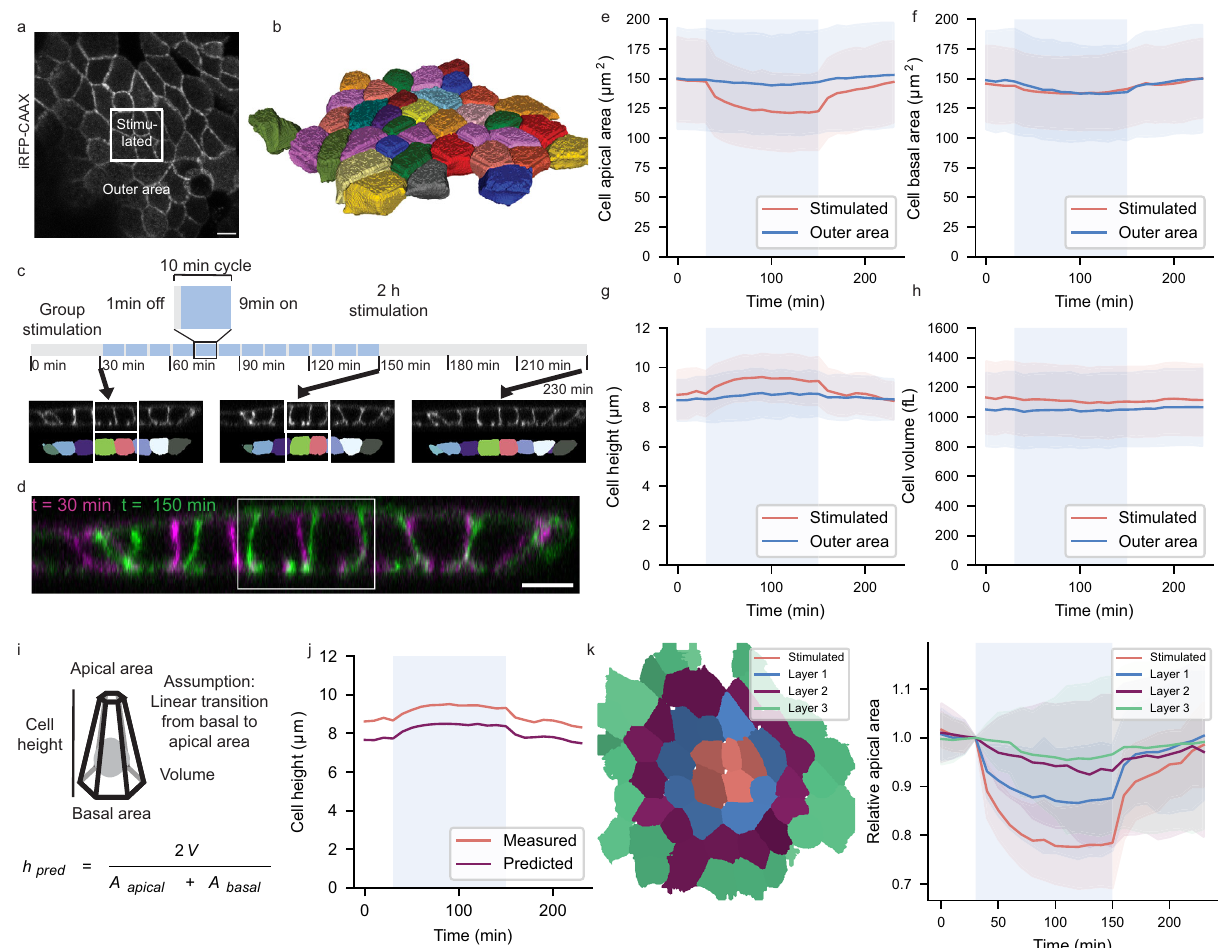
Fig. 2 | OptoShroom3-inducedcell elongation.a Apicalslice of iRFP-CAAX signal of MDCK cells on glass. The white box marks the stimulated area (26.5×26.5 μ m). Scale bar=10 μ m. b Reconstruction of a 3D segmented MDCK monolayer. c Cell groupstimulationcyclesandrepresentativeimagesfromconstrictionexperiments. LateralsliceofiRFPCAAXand3Dsegmentation. d Color-codedcompoundedimage comparing the start and end of stimulation. Scale bar=10 μ m. e – h Apical, basal